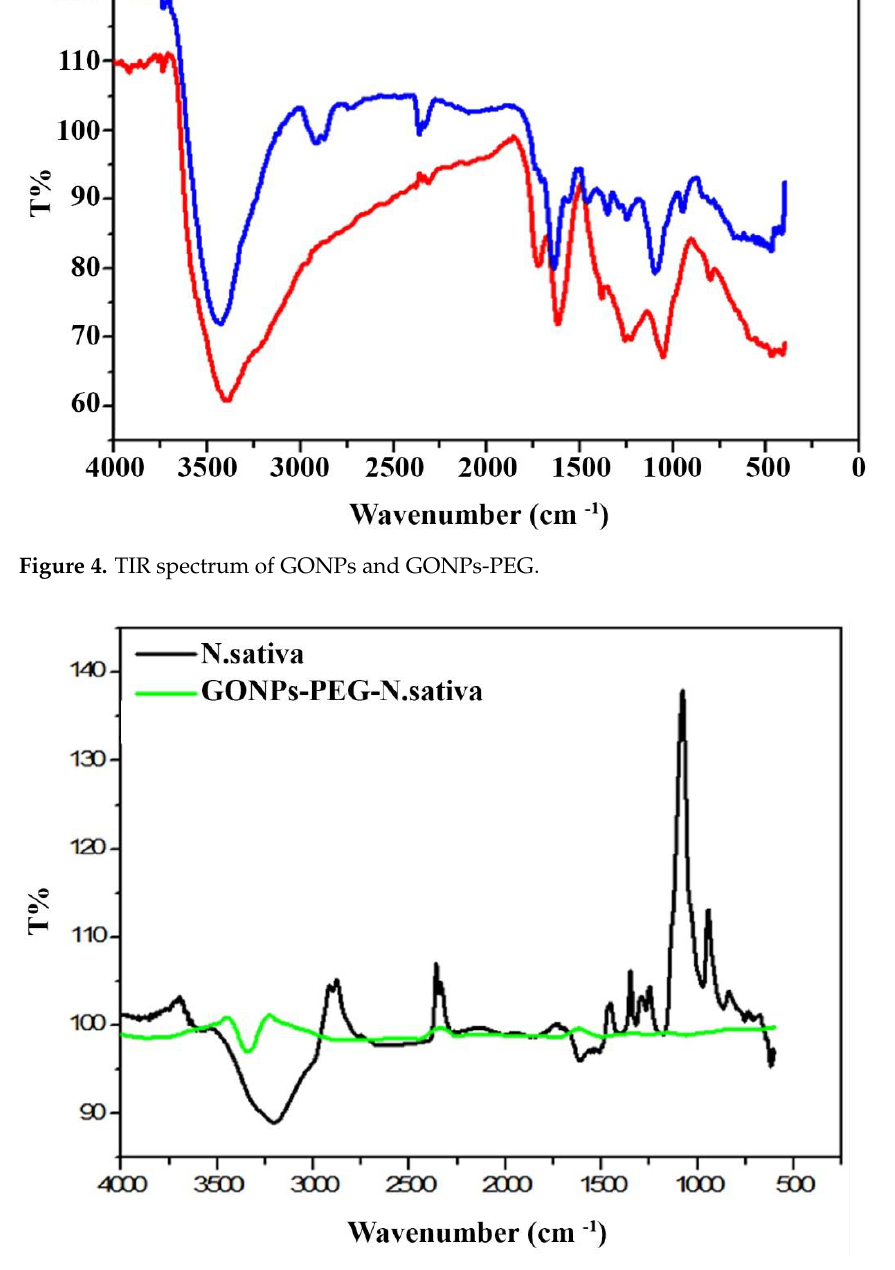
Figure 6. UV-vis absorption spectrum of GONPs, GONPs-PEG, N. sativa , GONPs-PEG- N. sativa . 3.5. Antibacterial Activity of GO, GO–PEG, GO–PEG–N. sativa The antibacterial effects of pure gold nanoparticles are viewed differently by re- searchers. Many researchers conclude that pure nanogold particles have no antibacterial properties or that the results are minimal. According to a study conducted by Zhang et al., gold nanoparticles have no or only slight bactericidal effects at high concentrations [29]. The effect of 15 nm gold nanoparticles on the antibacterial activity of gentamicin was investigated by Burygin et al. using a variety of methods at various concentrations of gen-